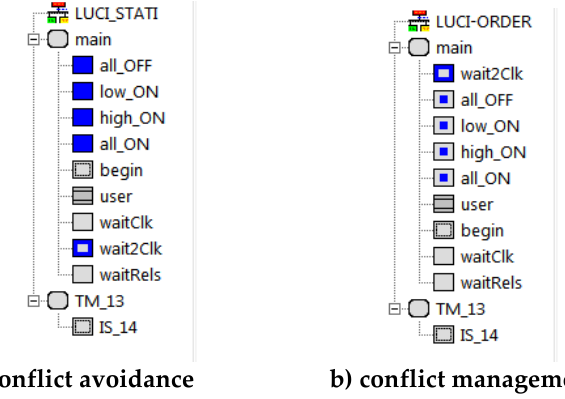
Figure 23. Different orderings for Step evaluation (with variable tracing shown).